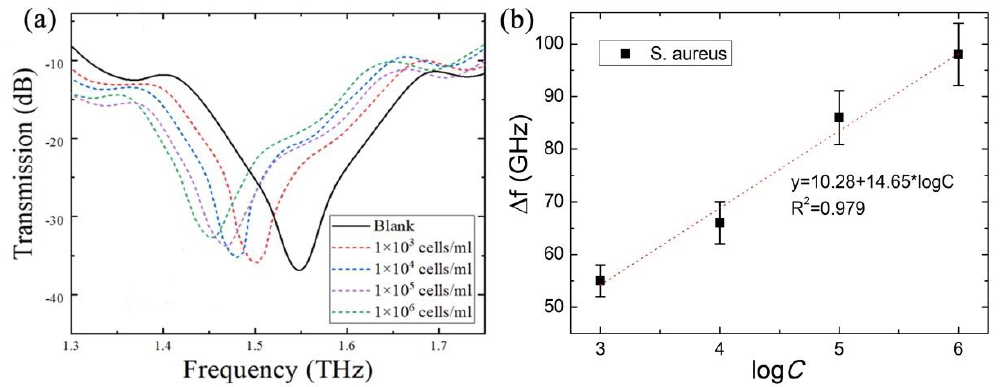
Figure 7. ( a ) Transmission spectra of the blank sensor and sensor covered by S. aureus sample at different concentrations. ( b ) Plot of ∆ f versus log C with the dash line being the fitting line.